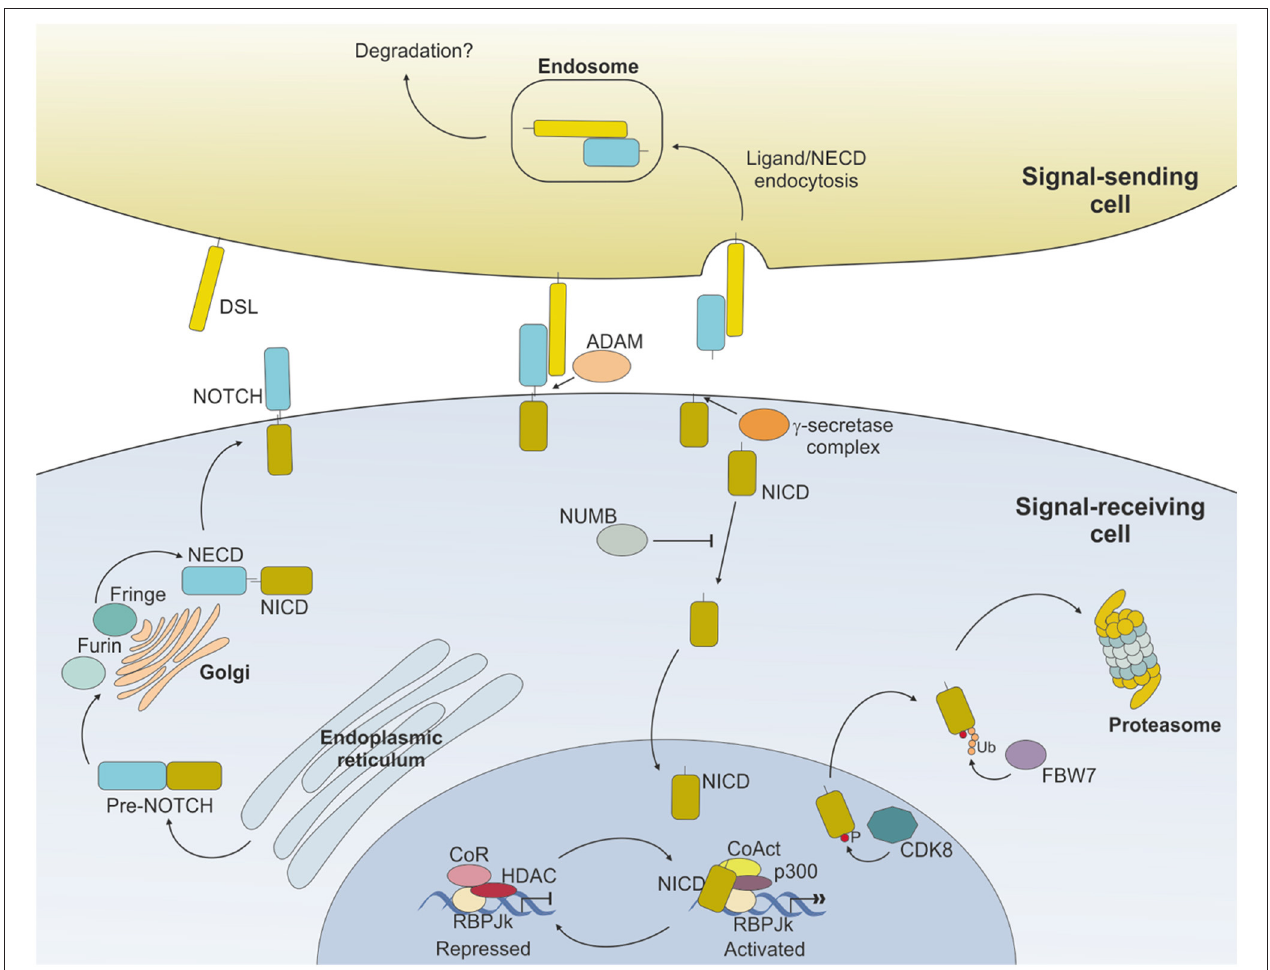
FIGURE 2 | NOTCH signaling pathway. Ligand expressed on the surface of the signal-sending cell binds to NOTCH expressed on the surface of the signal-receiving cell and induces sequential cleavages by A-Disintengrin-And-Metalloprotease (ADAM) and γ -secretase, ultimately releasing the NOTCH intracellular domain (NICD) from the membrane. NICD translocates to the nucleus where it mediates the displacement of co-repressors (CoR) and Histone DeAcetylase Complex (HDAC) and directly interacts with RBPJk recruiting co-activators (CoAct), finally inducing target gene transcription. The signaling pathway is shut down by phosphorylation of the NICD subunit by C/Cyclin-dependent kinase 8 (CDK8) and subsequently poly-ubiquitinated by F-box containing protein (FBW7) and degraded via proteasome. The strength and outcome of receptor-ligand binding can be modulated by post-translational modifications of NOTCH receptors, operated by the Fringe family of enzymes.